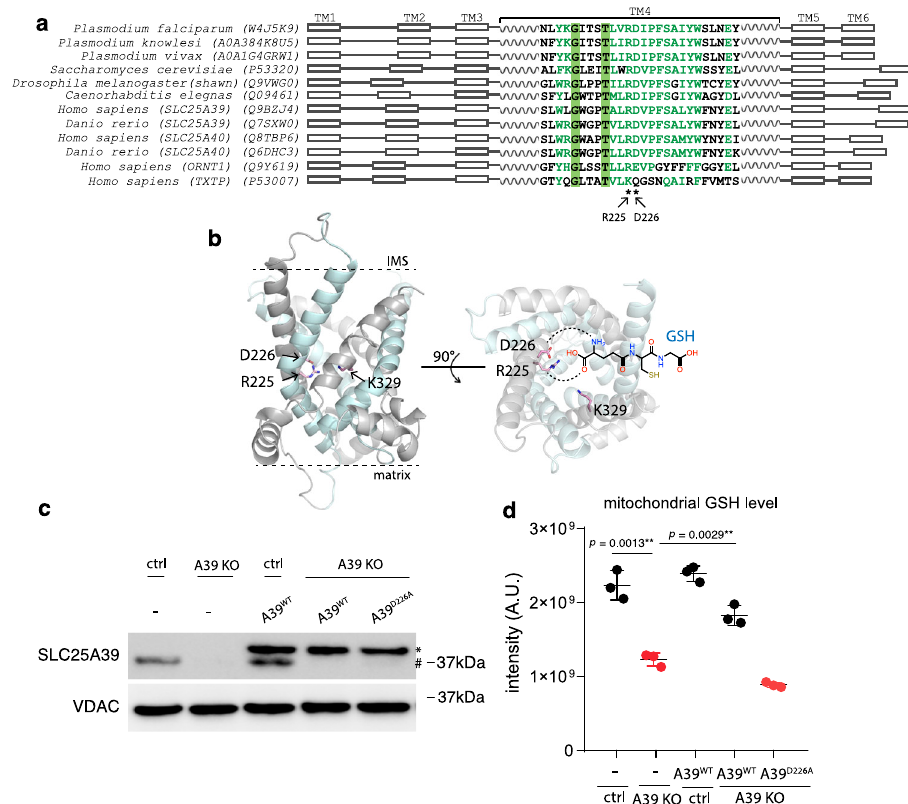
Fig. 5 Structural modeling and functional mutagenesis of SLC25A39. a Multiple sequence alignment of the eukaryotic A39 ortholog sequences spanning diverse taxa alongside with the human amino acid ornithine transporter SLC25A15 (ORNT1) and the human citrate transporter SLC25A1 (TXTP). The positions for the human SLC25A39 Arg225 and Asp226 residues predicted to bind amino acids are labeled by asterisks. b The modeled human A39 structure based on the ANT structure c-state conformation (PDB: 1OKC), in both side view (left) and cytoplasmic/mitochondrial intermembrane space (IMS) view (right). Odd transmembrane domain (TM1, 3, 5) are shown in gray and even (TM2, 4, 6) are shown in cyan. Two predicted GSH binding residues (R225, D226) and the predicted residue critical for solute-binding induced conformational change (K329) are shown. The predicted interaction between R225 and D226 with the carboxylate and amino group of the glutamate residue of GSH is shown by dashed line. c Western blotting showing the endogenous A39 (#) and ectopically expressed A39 protein (*). VDAC was used as the loading control. d LC-MS measurement of mitochondrial GSH level showing that the predicted substrate binding mutant A39 D226A cannot restore mitochondrial GSH level in the A39 KO cells ( n = 3). Statistical signi fi cance was calculated using two-tailed t test. Signi fi cance level were indicated as *** p < 0.001, ** p < 0.01, * p < 0.05 and n.s. p > 0.05. Data are expressed as mean ± SD. Source data are provided as a Source Data fi